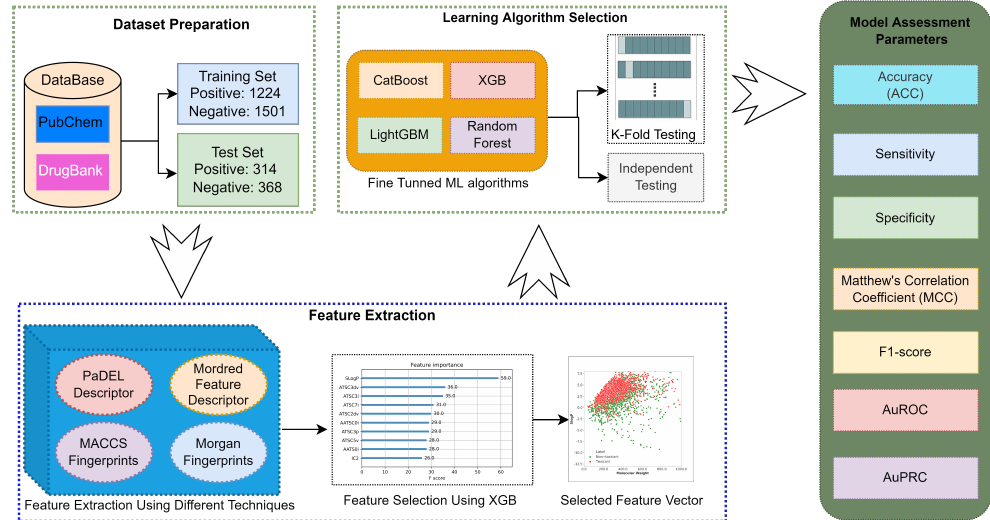
Figure 1. Development process of XML-CIMT